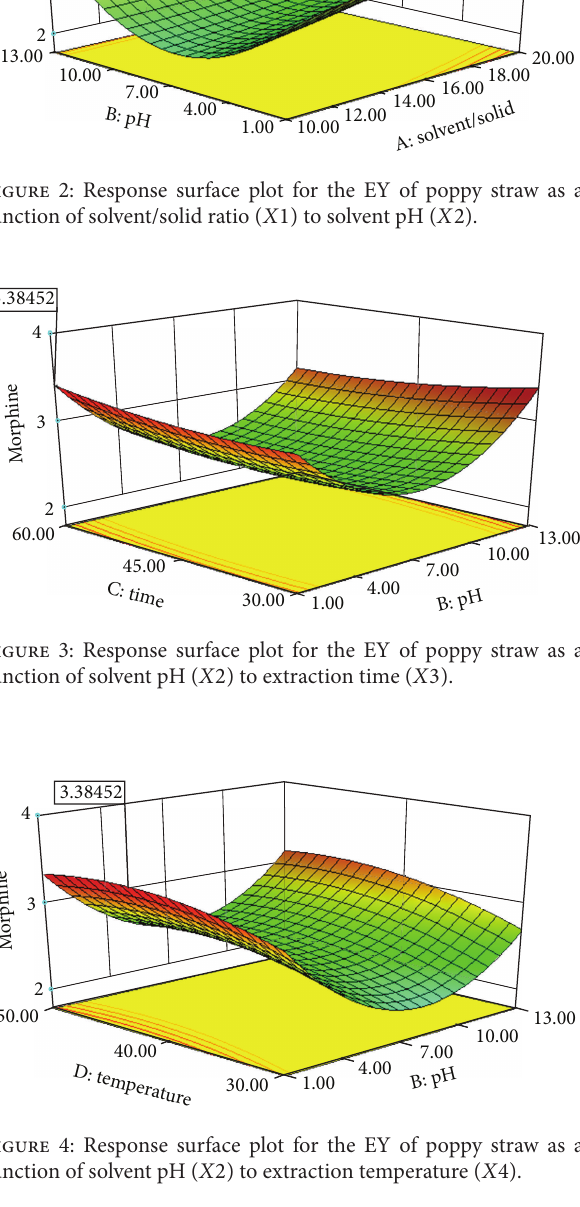
Figure 7: Response surface plot for the EY of poppy straw as a function of solvent/solid ratio ( 𝑋1 ) to extraction time ( 𝑋3